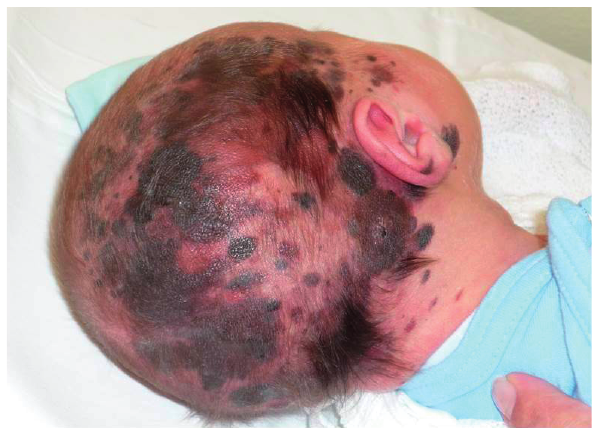
Fig. 1. congenital large melanocytic nevus of the head and neck at 14 days of age.